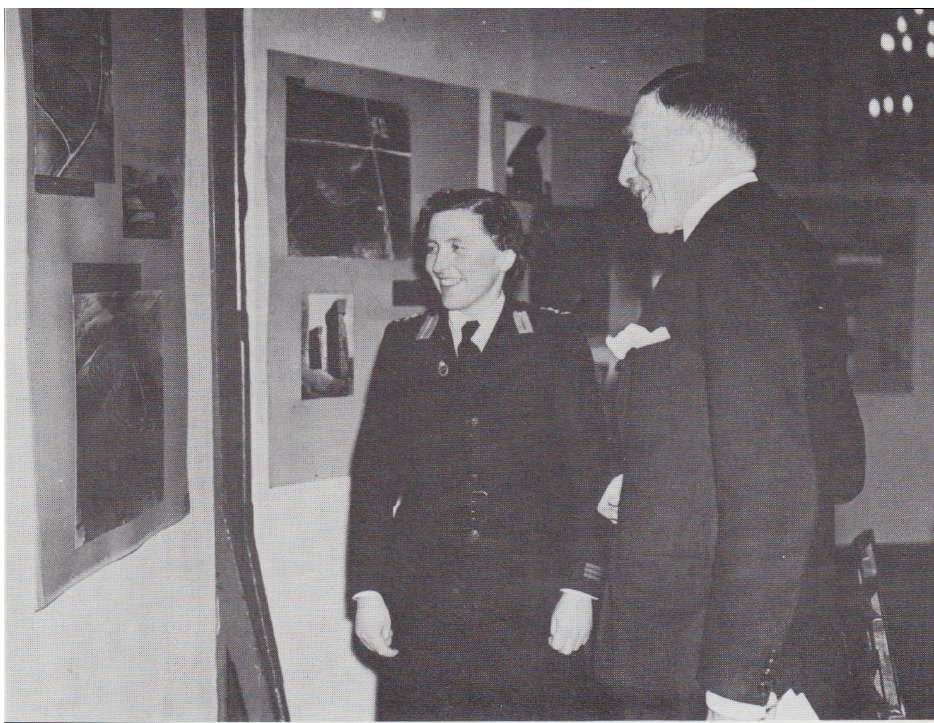
Fig. 3: Kathleen Kenyon in Red Cross uniform, in 1943, at the opening of an exhibition, ‘The Present Rediscovers the Past’, as Acting Director of the Institute of